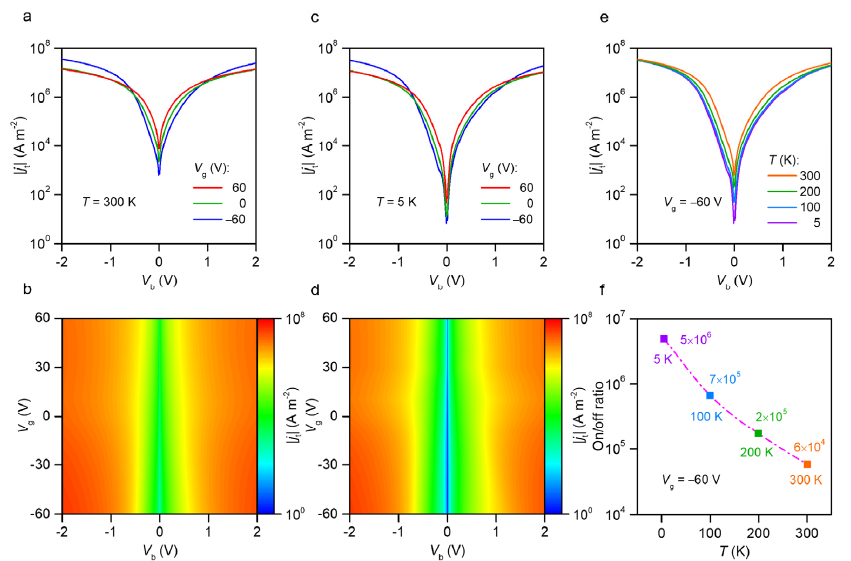
Figure 2. Tunneling current characteristics of GWMH devices. ( a ) Characteristic curves of tunneling current density versus bias voltage ( j t − V b ) under different gate voltages V g at 300 K. ( b ) Map of tunneling current density j t as a function of bias voltage V b and gate voltage V g at 300 K. ( c , d ) Characteristic j t − V b curves and j t ( V b , V g ) map at 5 K, respectively. ( e ) Tunneling current density j t versus bias voltage V b under gate voltage V g = − 60 V from 300 to 5 K. ( f ) Current on/off ratio under − 60 V gate voltage from 5 to 300 K.